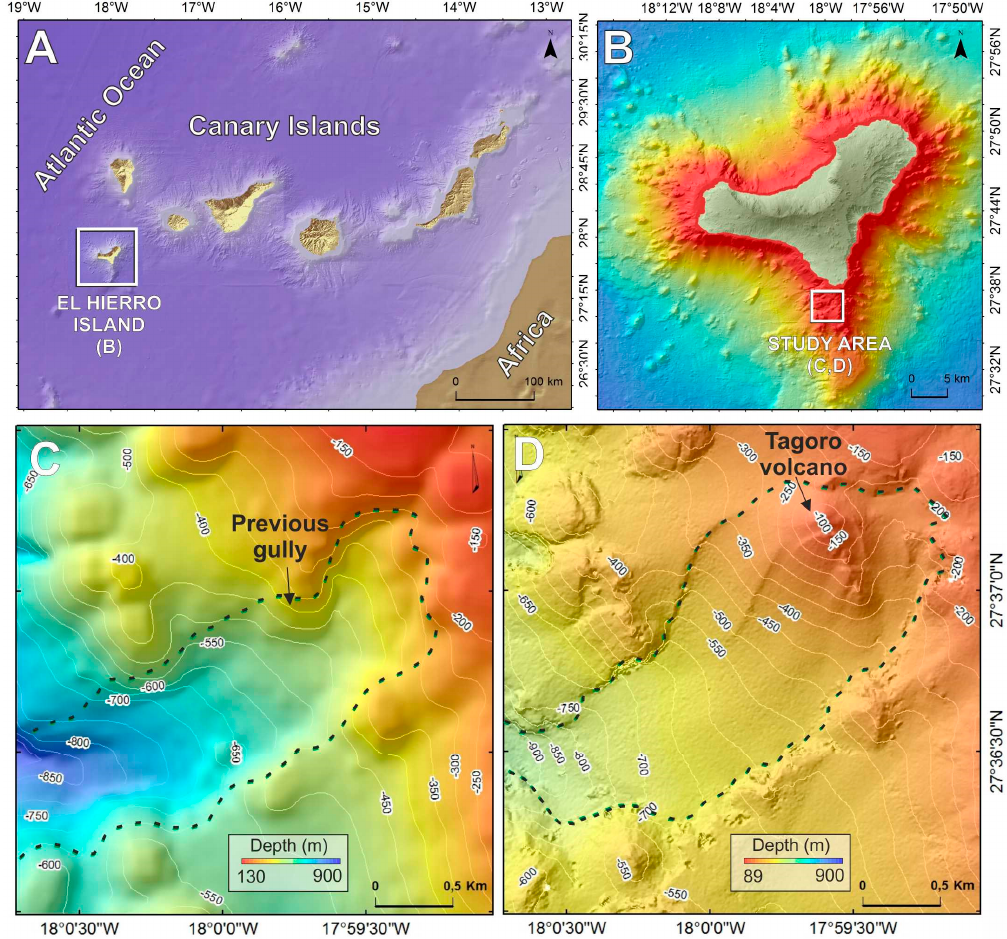
Figure 1. Overview bathymetric maps of the study area. ( A ) Geographical location of the El Hierro Island at the Canary Islands (Northeast, NE, Atlantic Ocean); ( B ) Study area location south of El Hierro Island; ( C ) Pre-eruption topography of the study area where the pre-eruption gully is highlighted; ( D ) Bathymetric map of the Tagoro volcano.